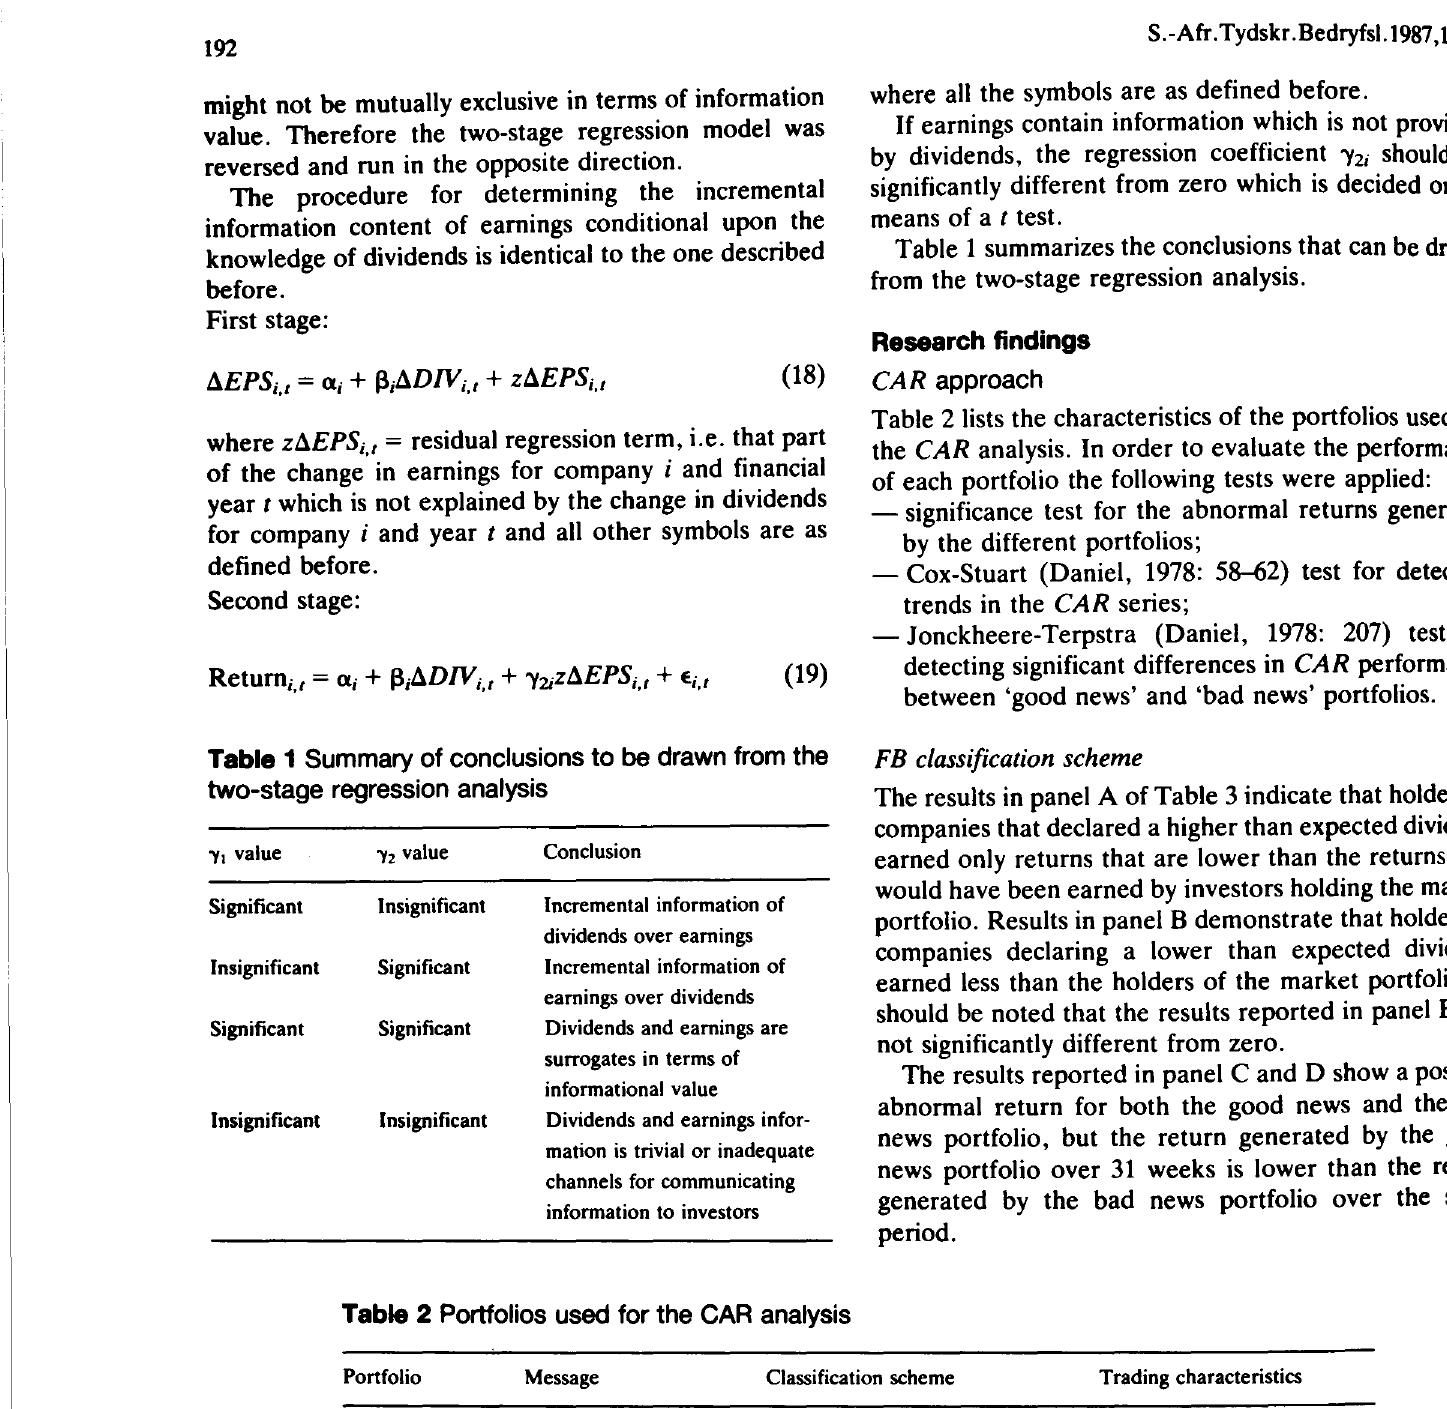
Table 2 Portfolios used for the CAR